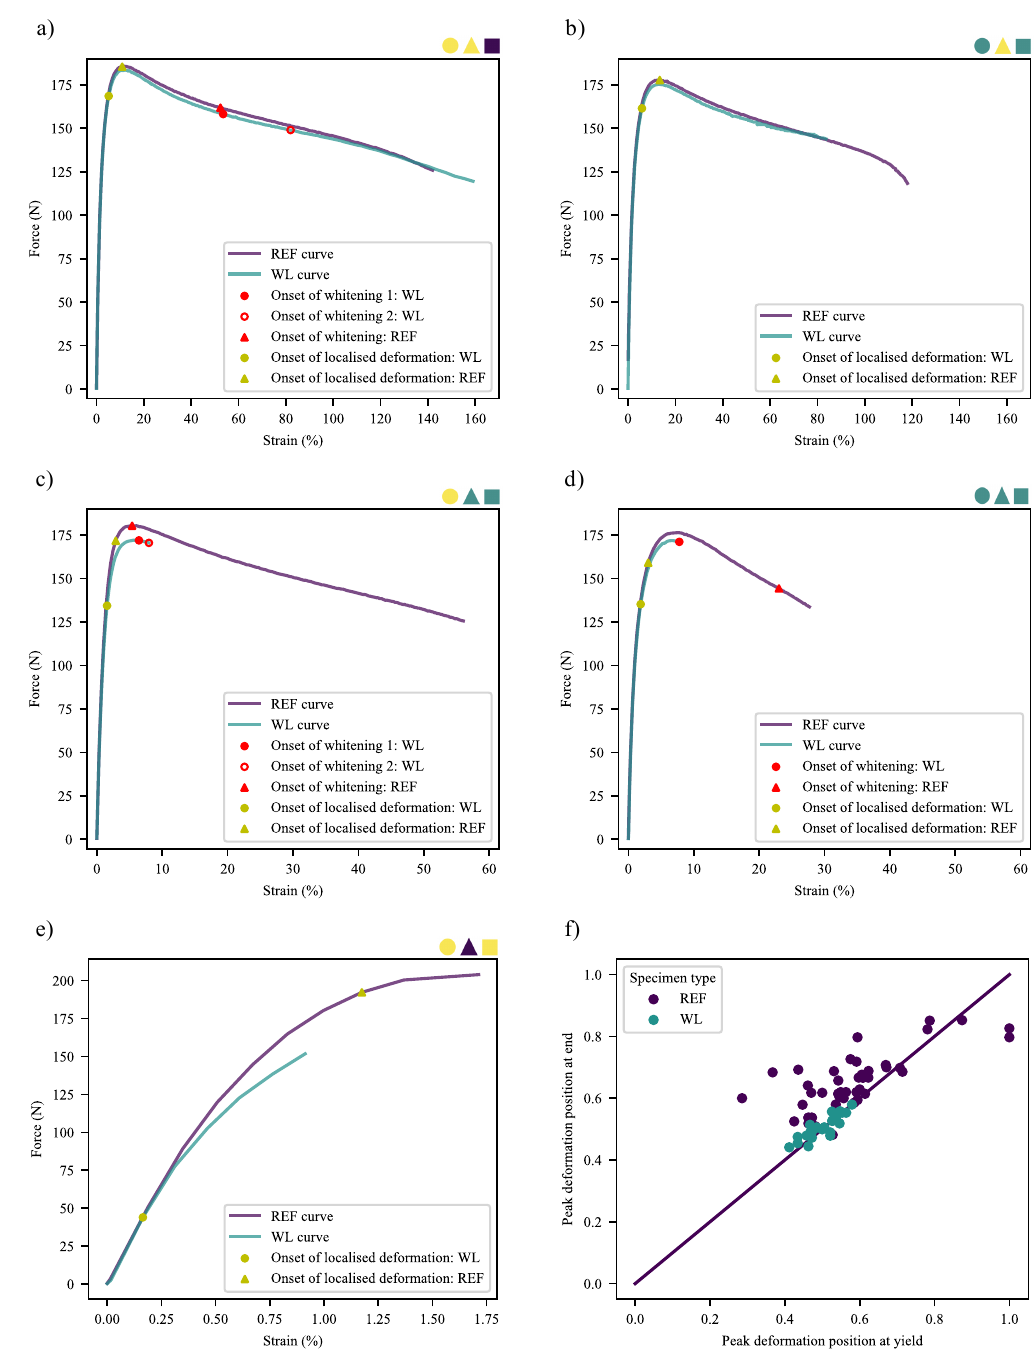
Figure 22. ( a – e ) Comparison of the peak-deformation-point force-strain curves for WL and REF specimens of ( a ) 0- CB/0-CC/0.5-SP, ( b ) 1.8-CB/0-CC/0.25-SP, ( c ) 0-CB/30-CC/0.25-SP, ( d ) 1.8-CB/30-CC/0.25-SP and ( e ) 0-CB/60-CC/0-SP, with markers for the onset of localised deformation and whitening. ( f ) Comparison of the maximum deformation positions for the yielding and last viable